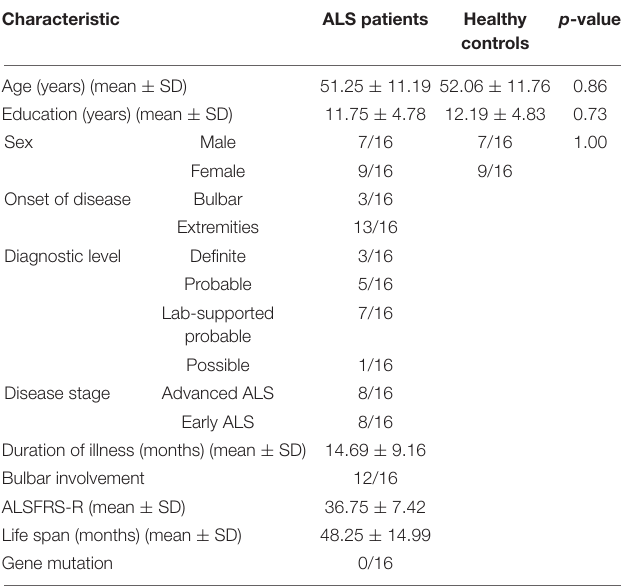
TABLE 1 | Characteristics of the participants: patients with ALS and healthy controls. Characteristic ALS patients Healthy